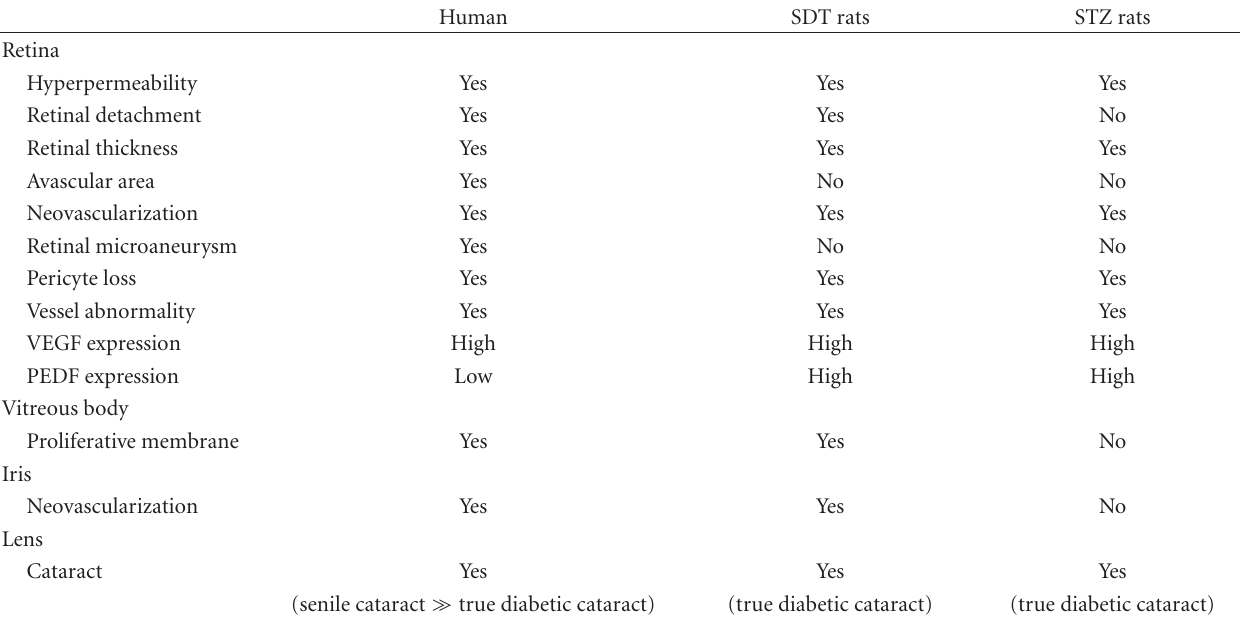
Table 1: Ocular pathological findings in diabetic human, SDT rats, and STZ-induced diabetic